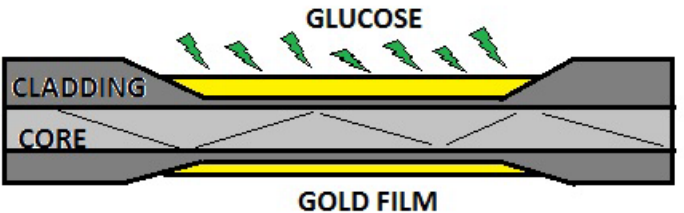
Figure 4. Tapered plasmonic fiber optic coated with gold film for increased sensitivity in the region tapered waist.